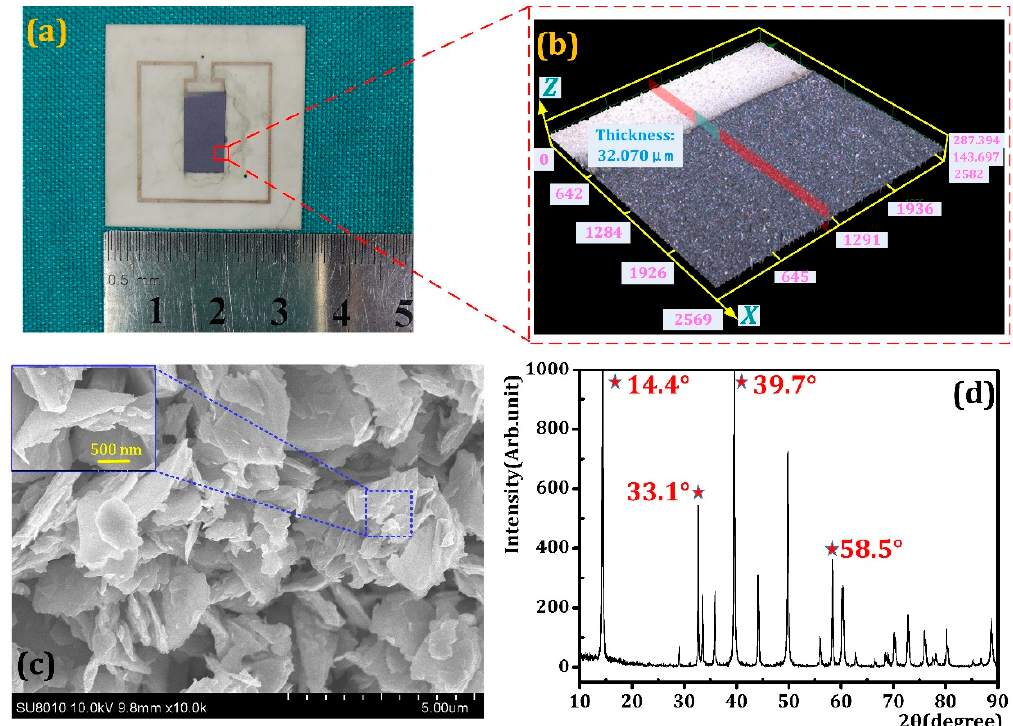
Figure 5. ( a ) The optical image of as-prepared LC humidity sensor; ( b ) the morphology result of as-sprayed MoS 2 film; ( c ) the microscopy of MoS 2 nanoflakes; and ( d ) X-ray diffraction patterns of MoS 2 nanoflakes.